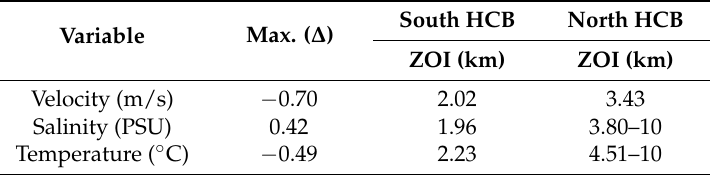
Table 5. Summary of zone of influence (ZOI) characterizing distances over which the difference in predicted maximum difference ∆ due to the presence of the bridge relative to the test 1 scenario without the bridge was reduced to 10% of its value. Results in this table are based on an average of all peak ebb and flood instances over the period of 25 April–11 June 2017 for velocity, and an average of all time steps for salinity and